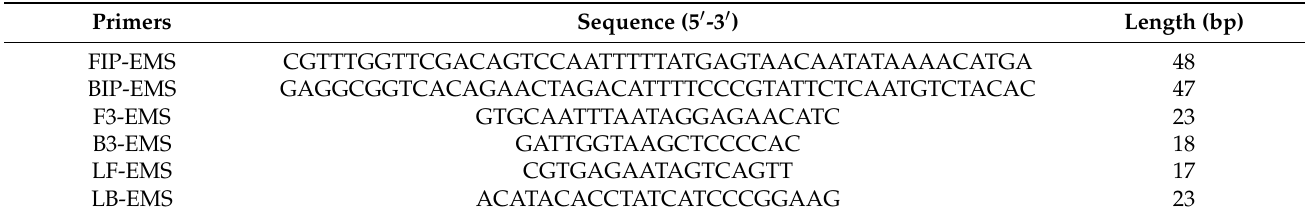
Table 4. Primer sequences used for EMS detection by LAMP